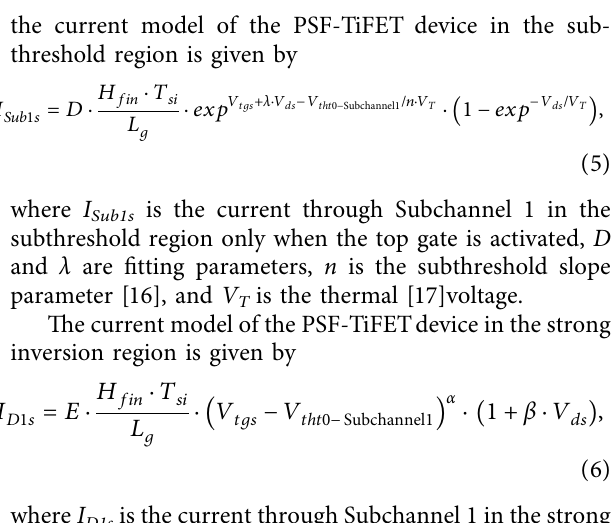
Figure 6: The simulation and calculated results of the current through Subchannel 1 and Subchannel 3 versus V tgs with V ds � 0.8V and V fgs � V bgs � 0V.